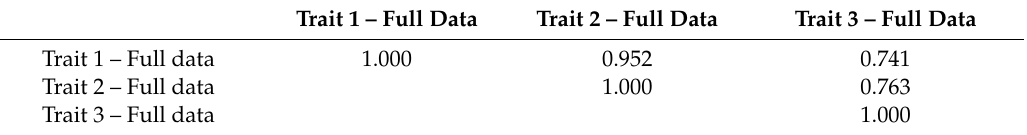
Table 5. Study 2: Expected Correlations Between Measures as Determined by Full Data.